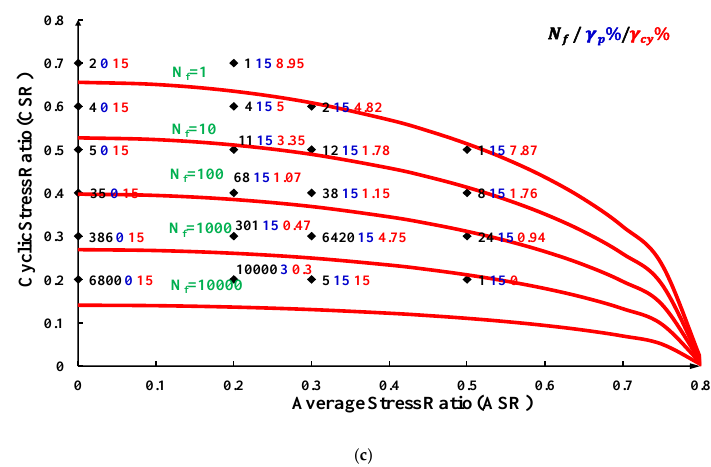
Figure 12. Proposed design curve procedure: ( a ) 200 kPa (Dr = 50%); ( b ) 300 kPa (Dr = 50%); ( c ) 200 kPa (Dr = 85%).